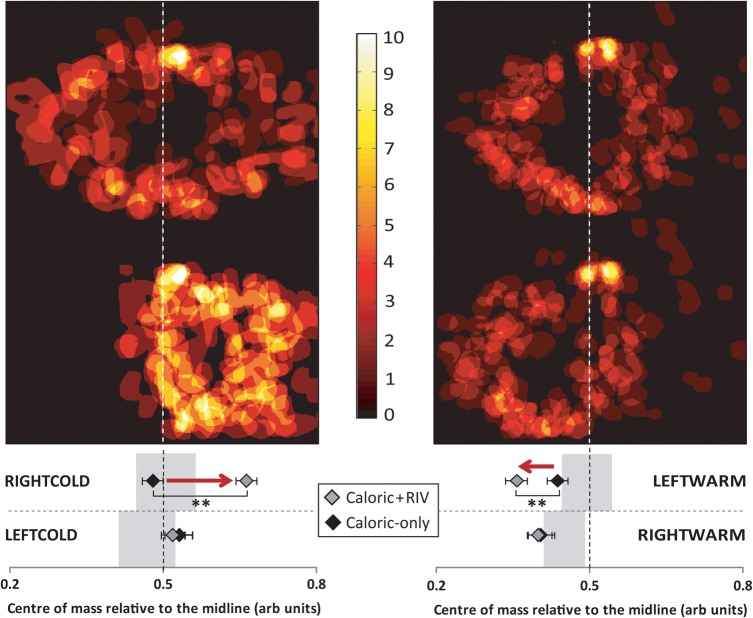
Heat maps (upper panel) illustrate numerical clock-drawing performance in caloric-only conditions (RIGHTCOLD on top left; LEFTWARM on top right) with corresponding ‘+RIV’ conditions below. Center of mass results are displayed in the lower panel: (A) (left panel) Following RIGHTCOLD + RIV when subjects were asked to draw the clocks clockwise (CW), a significant shift to the right (indicated by red arrow) is seen in the “Caloric + RIV” condition (gray diamonds) compared with “caloric alone” (black diamond) condition. (B) (right panel) Following LEFTWARM + RIV when subjects were asked to draw the clock anticlockwise (ACW), a significant shift to the left (indicated by red arrow) was observed in “Caloric + RIV” (grey diamonds) compared with “caloric alone” (black diamond) condition. Gray-shaded area in lower panels indicates 95% confidence limits calculated from baseline measures (i.e., no caloric or BR stimulation). Dashed line at 0.5 indicates the midline of a perfectly symmetrical clock. Data marked ** are significant at P < 0.01. Error bars indicate standard errors.